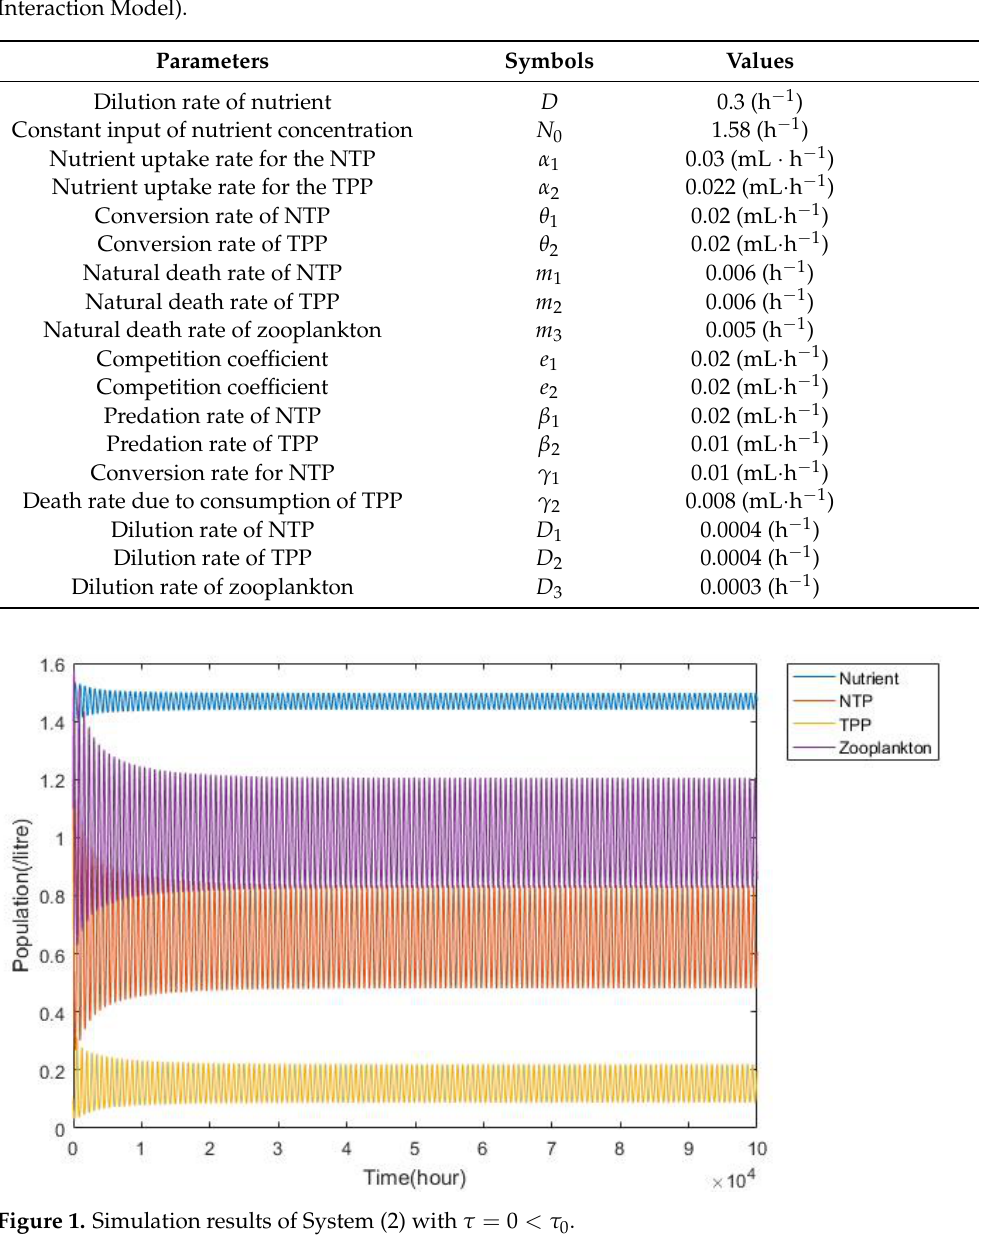
Table 1. Parameter values used in the numerical simulation (Nutrient–Phytoplankton–Zooplankton Interaction Model).